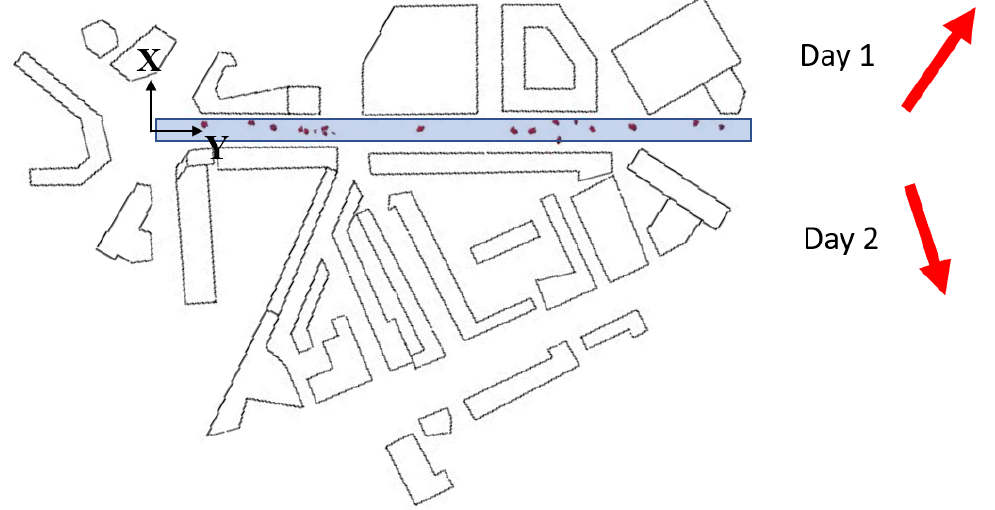
Figure 4. A snapshot of moving vehicle sources (red) and volume source (blue) along London Road. The coordinate system, with Z vertical, is also shown. The prevailing wind direction for both days is indicated by the red